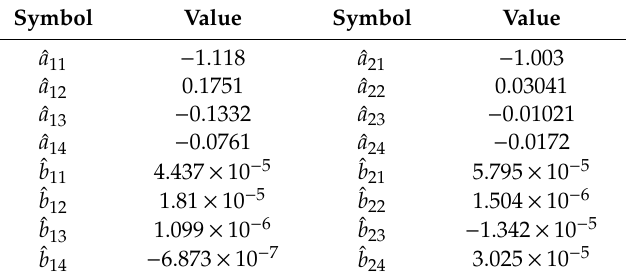
Table 1. Identification values of the model parameters.